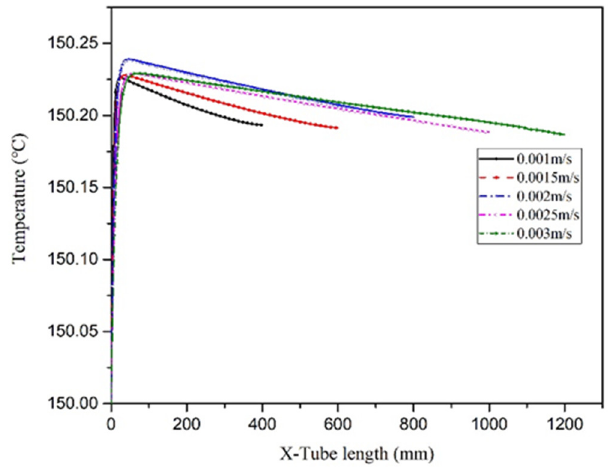
Figure 28. Temperature curves of the central axis at different inlet flow rates.